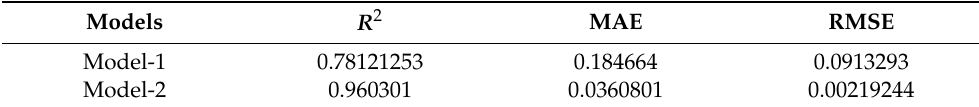
Table 4. Cross ‐ validation score.